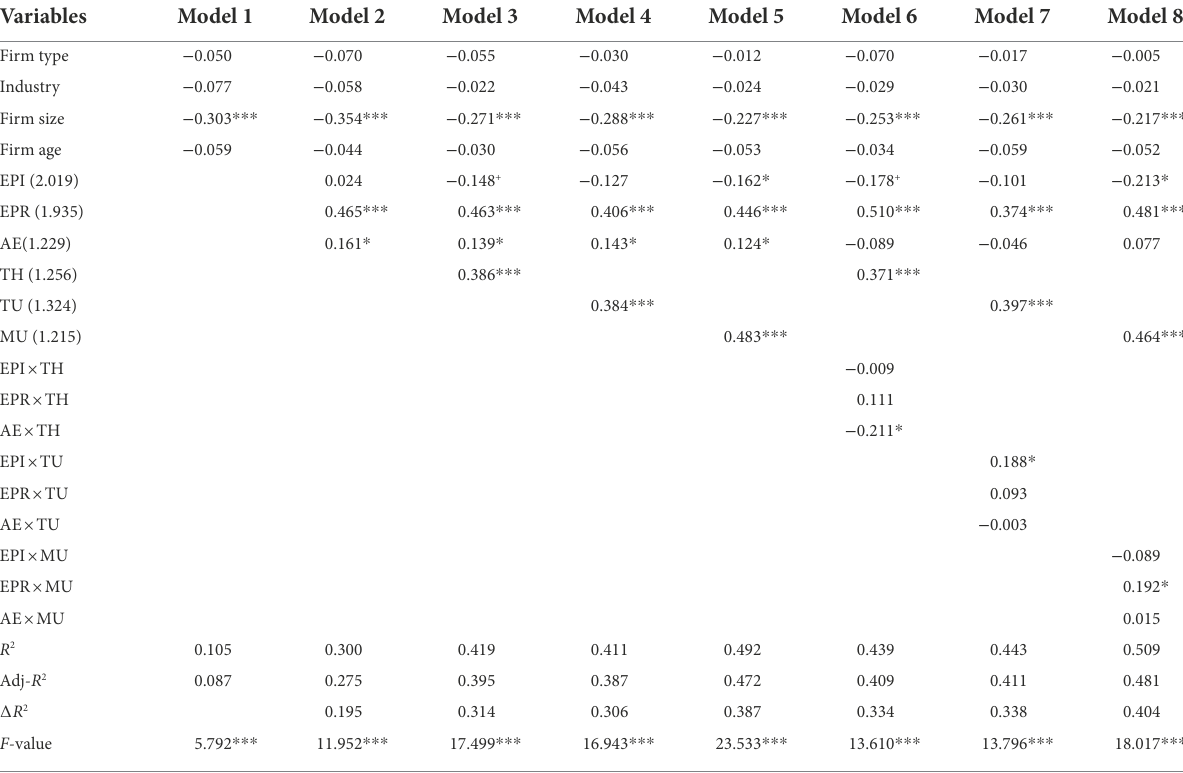
TABLE 5 The results for regression analysis ( N =